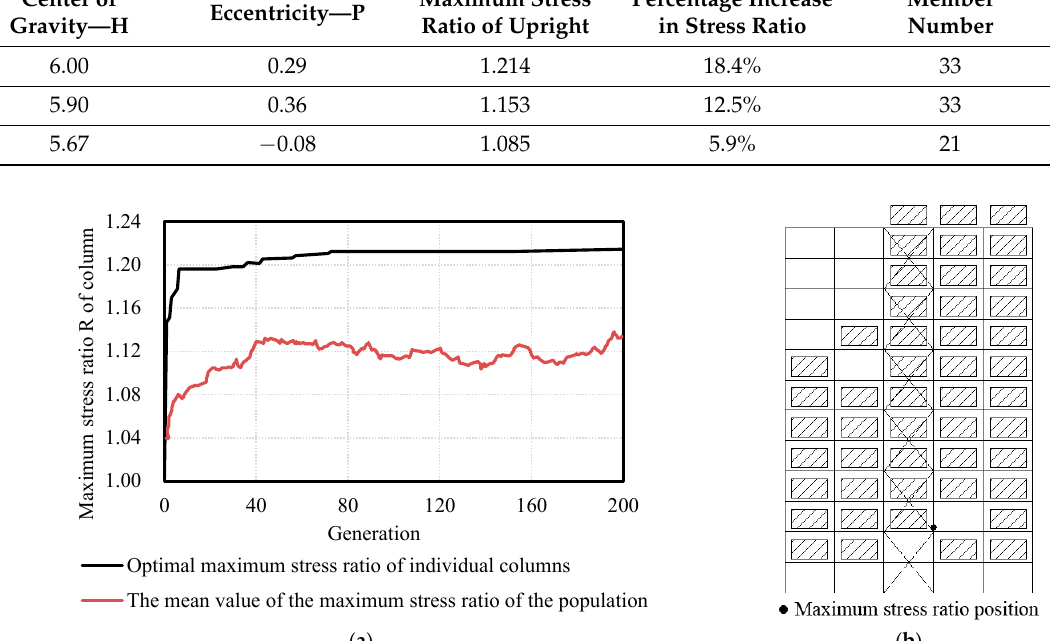
Figure 6. The most unfavorable distribution of load under 80% full load. ( a ) Tracking chart of optimization performance of GA. ( b ) The most unfavorable distribution of load (H = 6.00, P = 0.29).